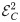
Short-time regime of (a) the total energy current J(t), (b) the energy current J
1(t) induced only by the reservoir of temperature T
1 and (c) the energy current J
2(t) induced by the reservoir of temperature T
2 for selected values of the rescaled external magnetic flux Φe.The reservoir rescaled temperatures are θ
1 = k
B
T
1/ℏω
B = 1, θ
2 = k
B
T
2/ℏω
B = 10. Remaining parameters are fixed as: εJ = 10, EC2 = 0.1 and γ
1 = γ
2 = 0.05. The dimensionless time t is rescaled by the oscillator frequency ω.